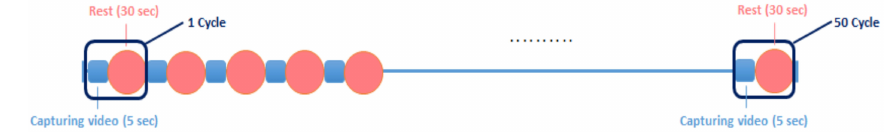
Figure 9. Data acquisition process for